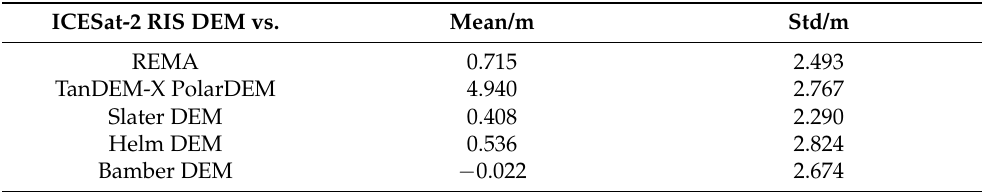
Table 4. Comparisons between the ICESat-2 RIS DEM and five previously published Antarctic DEMs. ICESat-2 RIS DEM vs.